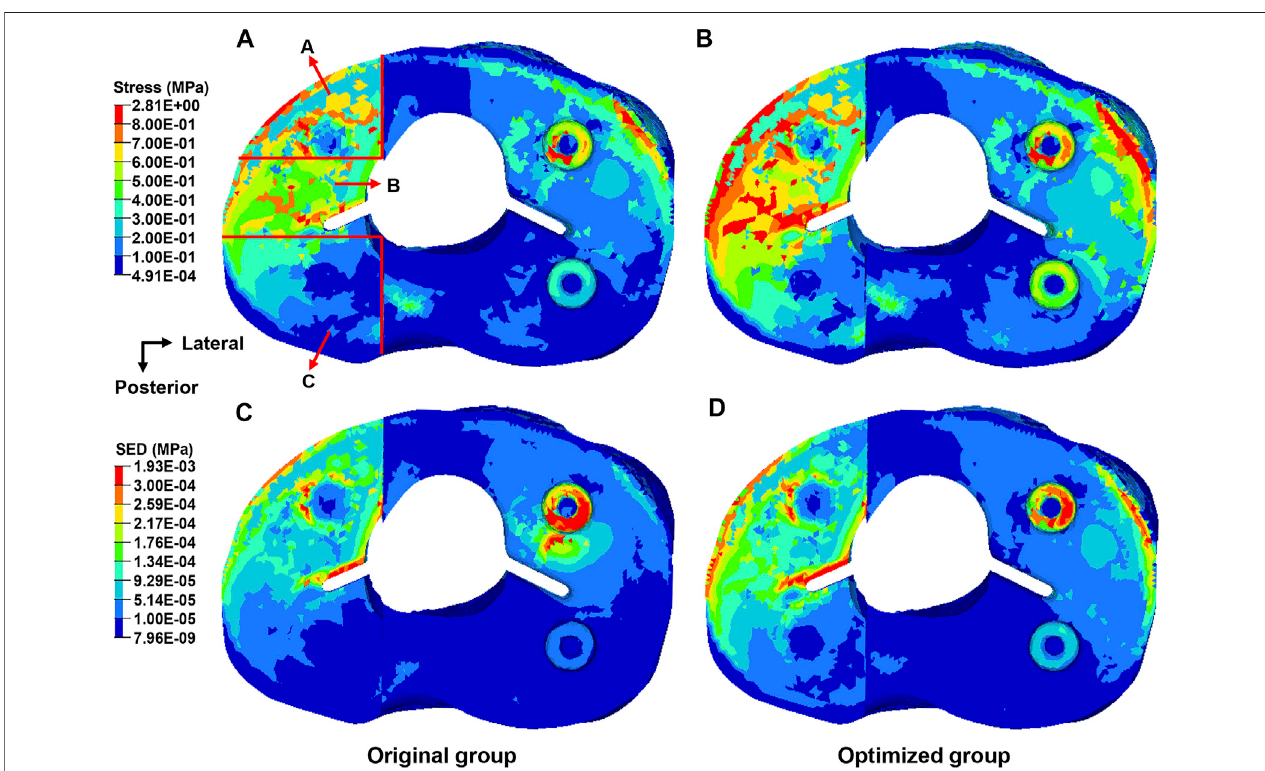
FIGURE7| DistributionofthevonMisesstressandstrainenergydensityintheproximaltibiafromthetopview. (A) Distributionofthestressintheoriginalgroup. (B) Distribution of the stress in the optimized group. (C) Distribution of the strain energy density in the original group. (D) Distribution of the strain energy density in the optimized group.